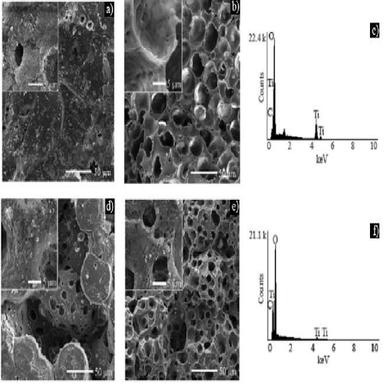
Images of 1 PLACHLA + TiO2 sample a) SEM surface, b) SEM cross-section, c) EDX spectra and 2 PLACHLA + TiO2 sample d) SEM surface, e) SEM cross-section, f) EDX spectra.